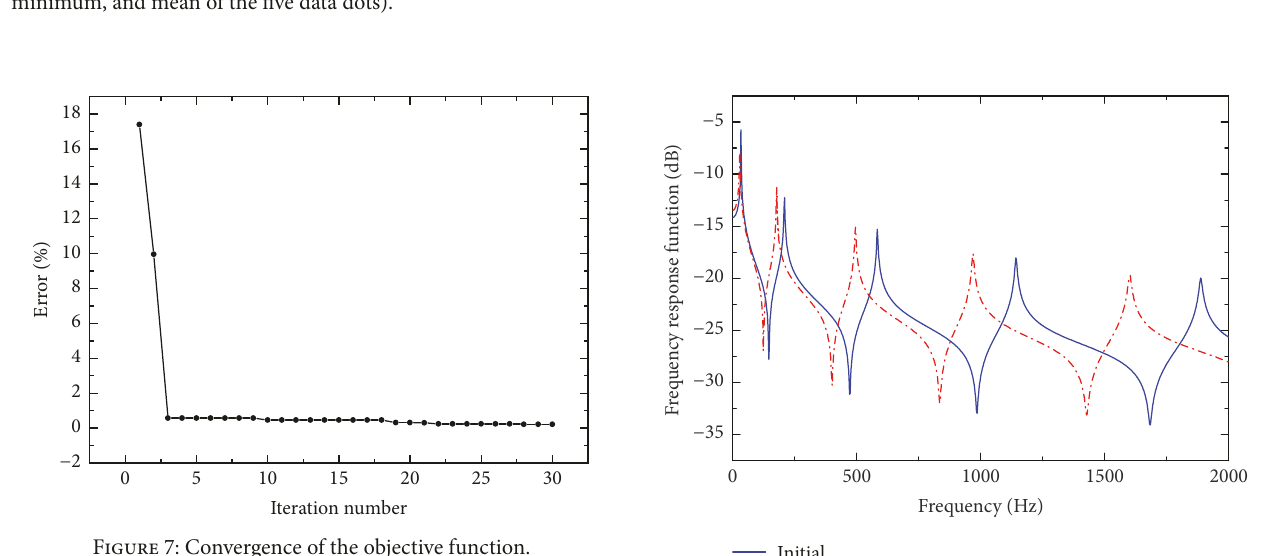
Initial Figure 8: Frequency response function before and after updating. results show that the composite material properties were identified as suitable which demonstrates the power and efficiency of the proposed spectral model and the model updating strategy for parameter